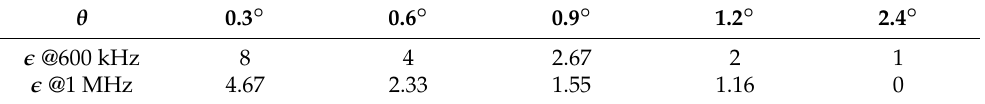
Table 1. Superposition of rays considering different sensor configurations and